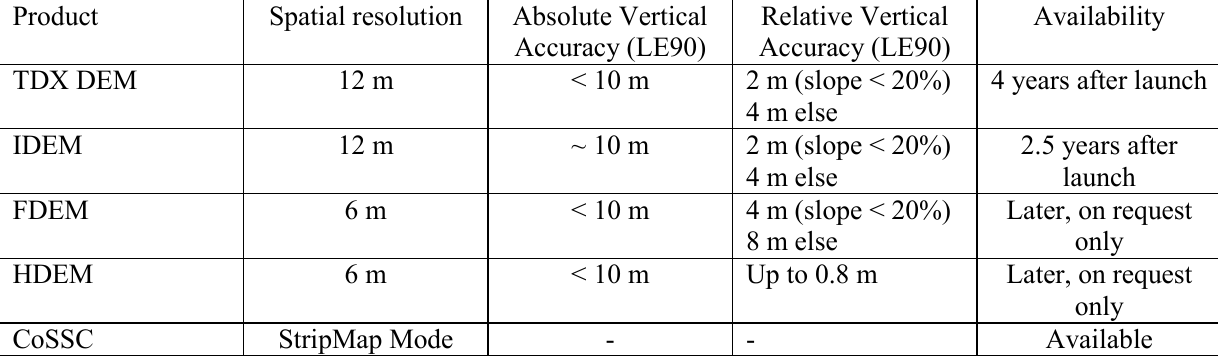
Tab. 1: Products of TanDEM-X Mission (TDX). Both the TDX DEM and the IDEM (intermediate DEM) shall be in addition provided with reduced resolution by factor 2 and 4 which in turn feature improved relative accuracy. In contrast FDEM (finer pixel spacing) will lead to larger lower relative accuracy, whereas HDEM is a high resolution DEM for which additional image pairs have to be taken with larger baselines. FDEM and HDEM will be delivered after the standard product. Finally, the CoSSC is not a DEM but a corigistered complex image pair in slant range